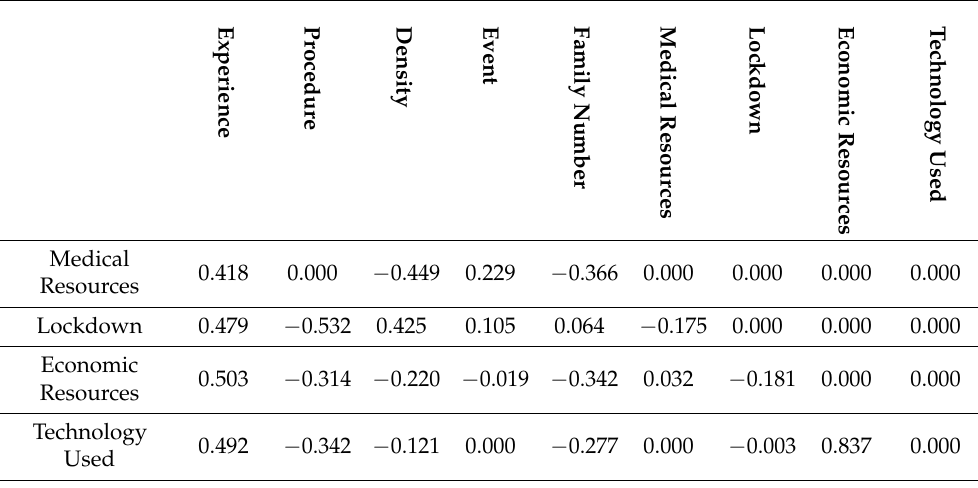
Table 8. Standardized total effects of exogenous variables on endogenous variables.